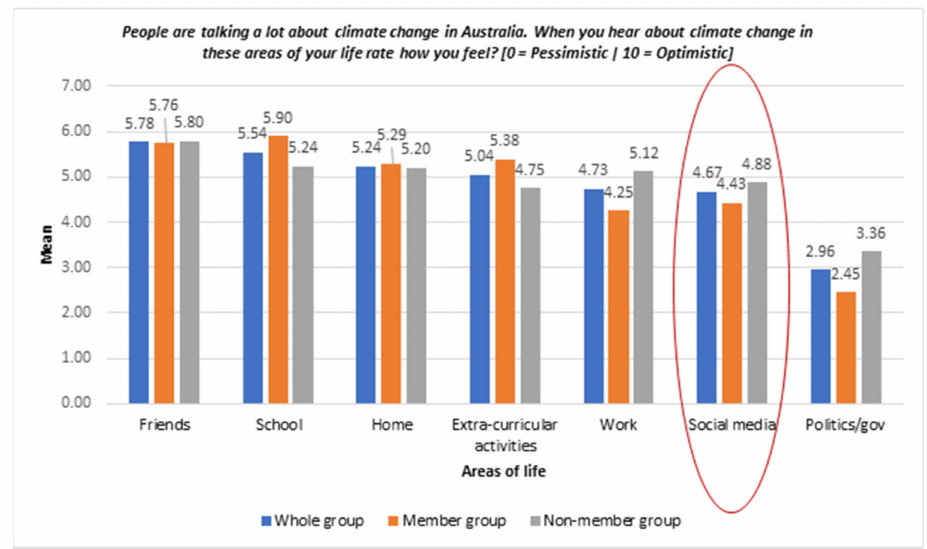
Figure 3. Bar chart of feelings related to talking about climate changes in different areas of life—whole sample and between groups. Red circle highlights how young people feel when they hear about climate change on social